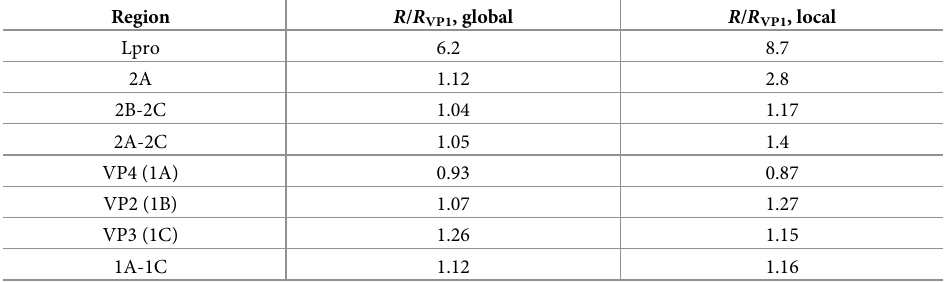
Table 1. Relative intra-host recombination rates inferred among different parts of the capsid-coding sequence and flanking